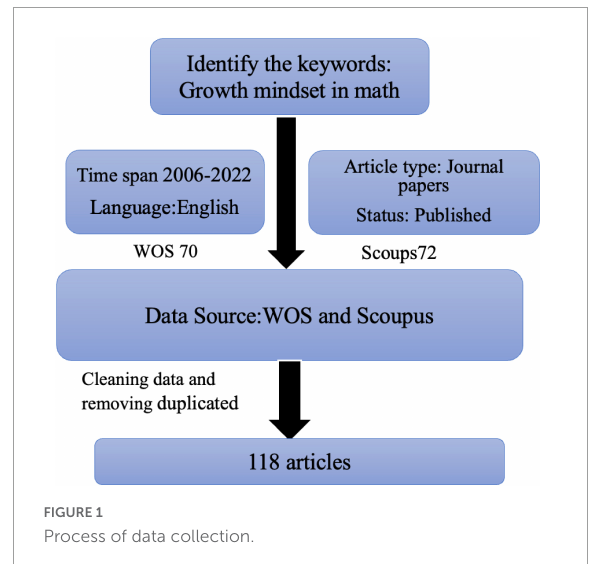
FIGURE1 Process of data